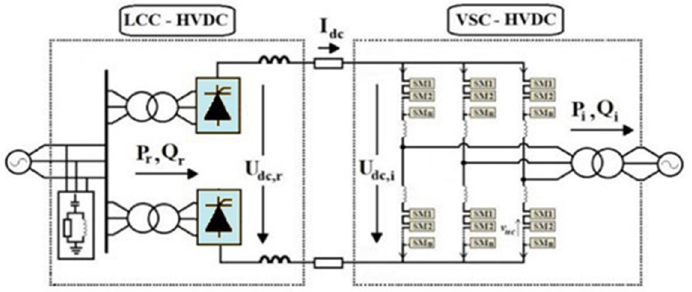
Figure 25. Hybrid VSC-CSC HVDC link.